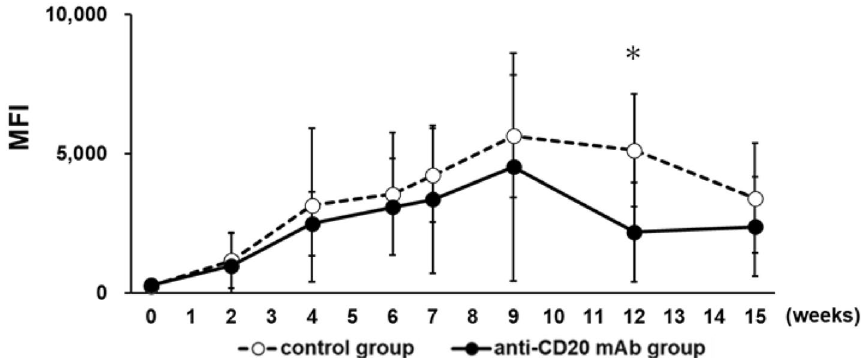
Figure 2. Kinetics of anti-donor Ab titers after allogenic skin transplantation. Donor C57BL/6 mouse tissues were transplanted twice onto the backs of the recipient Balb/c mice at 2-week intervals (weeks 0 and 2). Four weeks after the second skin transplantation (at week 6), recipient Balb/c mice were injected intravenously with 250 μg of the anti-CD20 murine IgG2b mAb (anti-CD20 mAb group, n = 5) or isotype control (control group, n = 5). The production of anti-C57BL/6 Abs in the sera of recipient Balb/c mice were evaluated with sera diluted 25-fold. Data are presented as MFI ± SEM; dotted line, control group; black line, anti-CD20 mAb group; * p < 0.05.